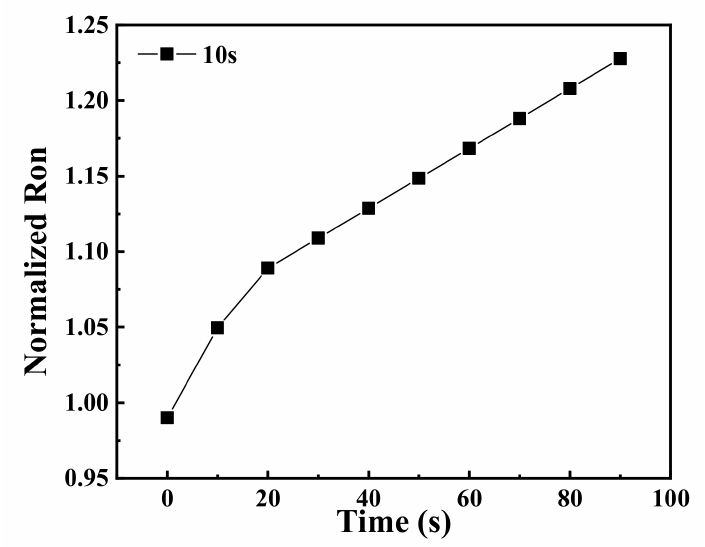
Figure 5. Normalized R ON value for increasing stress times with shorter intervals at 100 V off-state voltage.